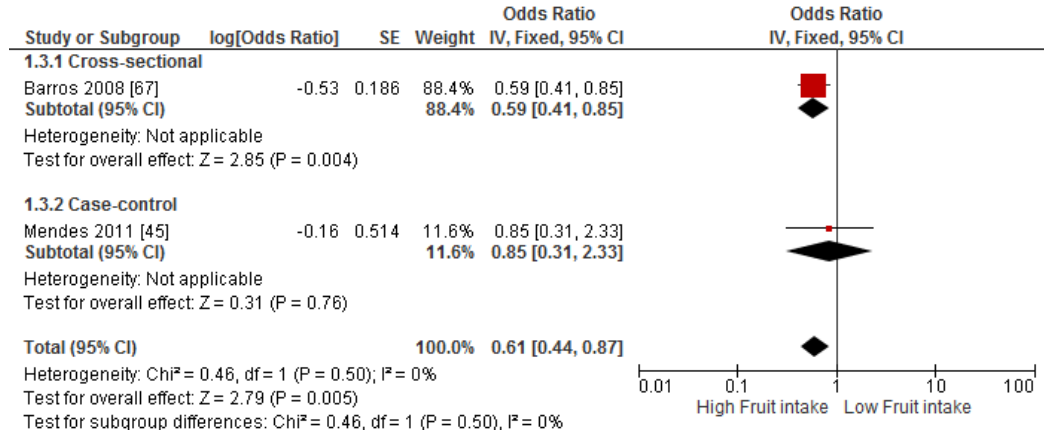
Figure 4. Meta-analysis of the association between fruit intake and severity of Figure 4. Meta ‐ analysis of the association between fruit intake and severity of asthma.